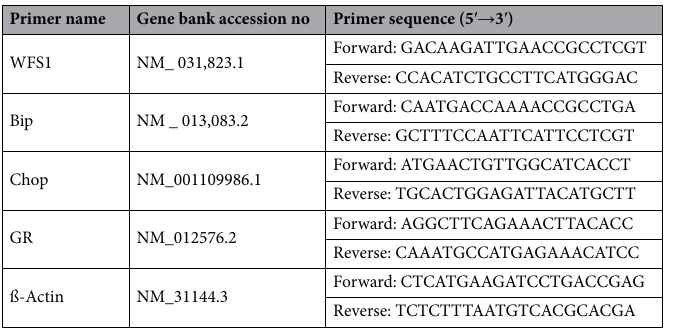
Table 2. Primers used for real-time PCR analysis. WFS1 wolframin ER transmembrane Glycoprotein, Bip (Hsp70) heat shock protein family A member 4, Chop (Ddit3) DNA-damage inducible transcript3, GR (Nr3c1) nuclear receptor subfamily 3, group C, member